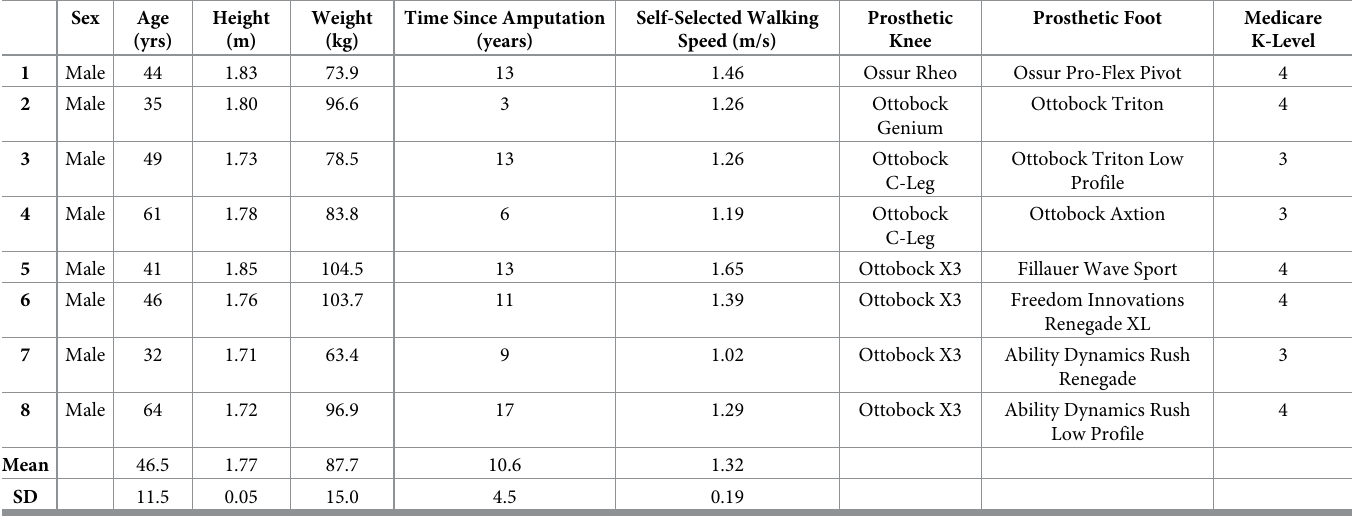
Table 1. Data for Participants at their pre-POP implantation